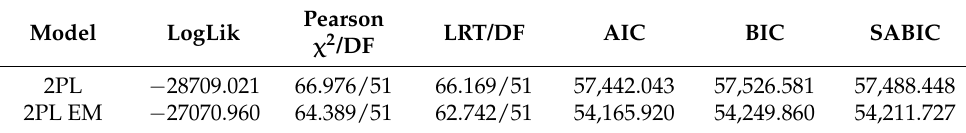
Table 1. Comparison between 2-PL model and effort-moderated model.